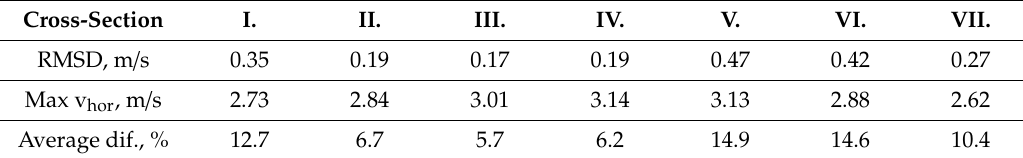
Figure 5. Measured and calculated cross-sectional horizontal velocity distributions. Table 1. The root-mean-square deviation (RMSD) between the measured and calculated velocities, the maximum cross-sectional horizontal velocity and the percentage deviation of them for the seven